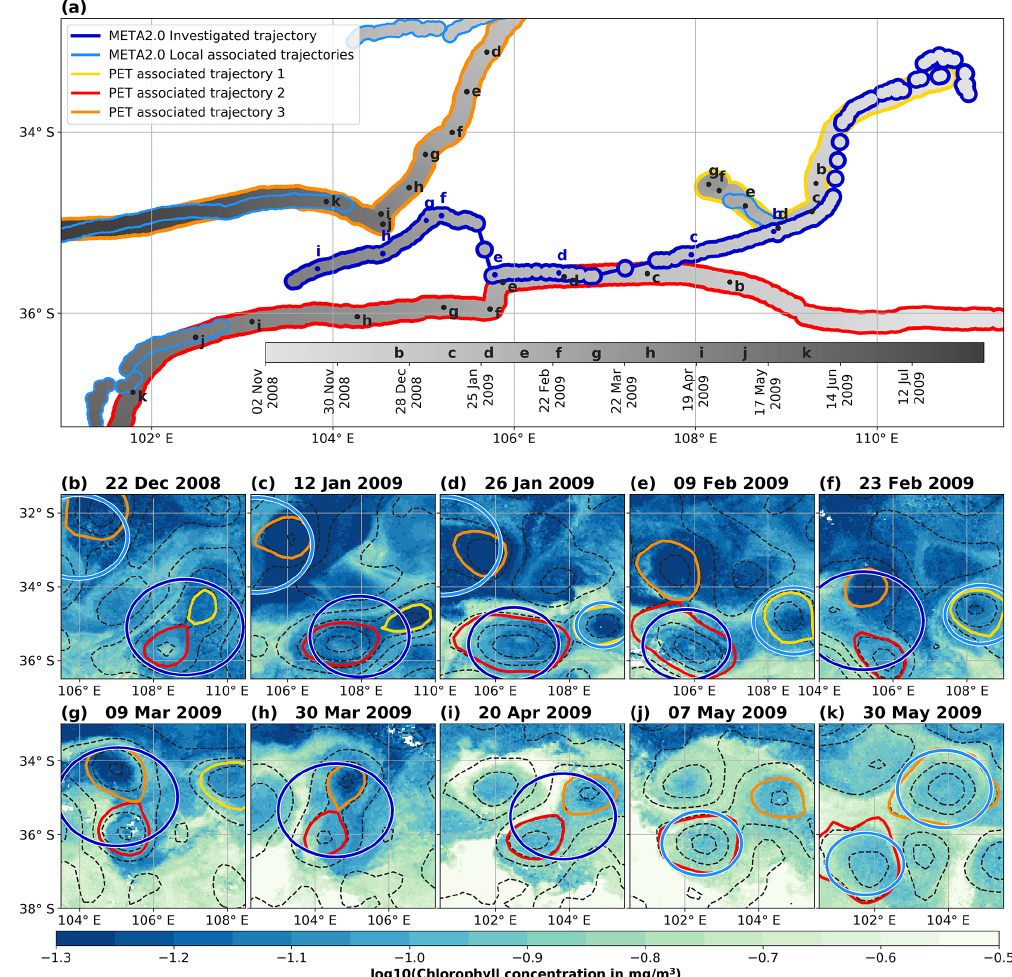
Figure 9. Selected eddies detected by both OSU (META2.0) and PET algorithms. The input field (filtered SLA) is identical for both detections, as is the tracking method (restricted area method). Eddies were selected as representative examples, highlighting the differences between the two detection algorithms. Panel (a) shows six META2.0 trajectories (the dark blue investigated trajectory, and five smaller ones in light blue) and three PET trajectories (yellow, red, and orange) for eddies detected over the same temporal period, from November 2008 to January 2009 (color scale). Dashed black lines in panels (b) – (k) show arbitrary 10cm levels of filtered SLA. Background colors in panels (b) – (k) show chlorophyll a concentrations in logarithmic scale (data courtesy of CLS). Note the reverse color scale, showing high concentrations in light colors. Letters in panel (a) correspond to the snapshot time of panels (b) – (k) ; panel (a) trajectories outline colors corresponding with the contours in panels (b) – (k)